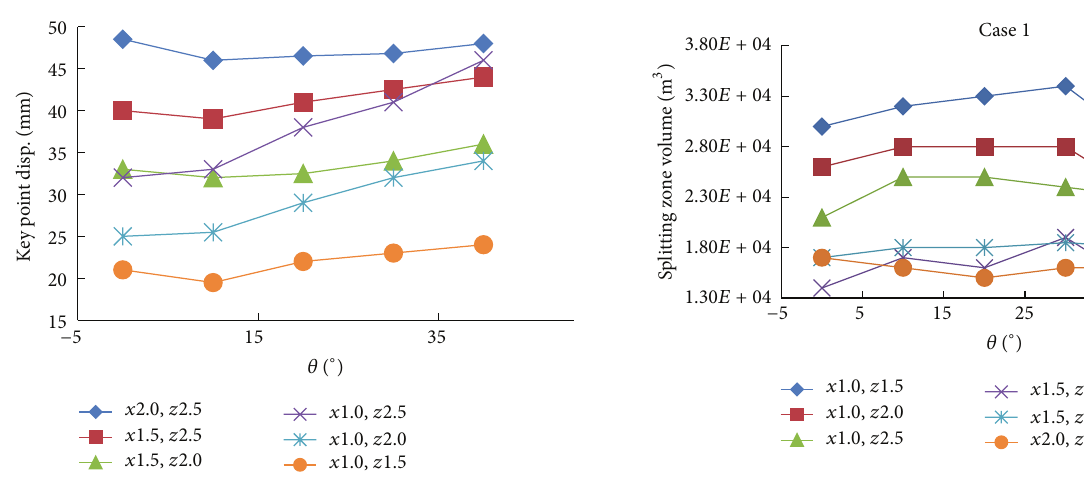
Figure 26: Splitting zone volume versus 𝜃 in case 1 .